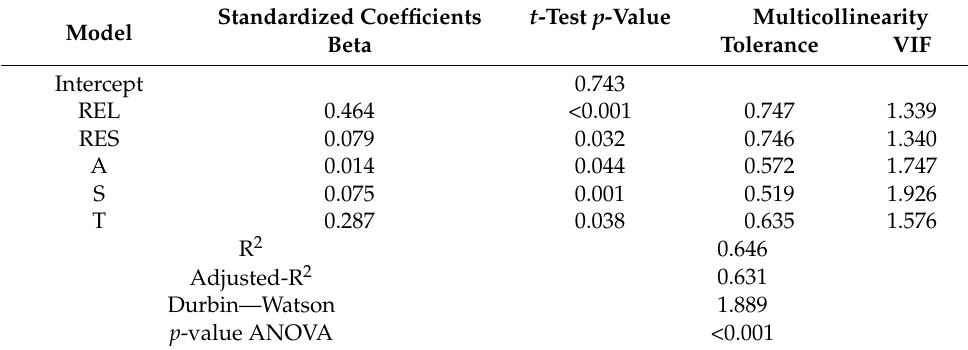
Table 6. Multiple-regression